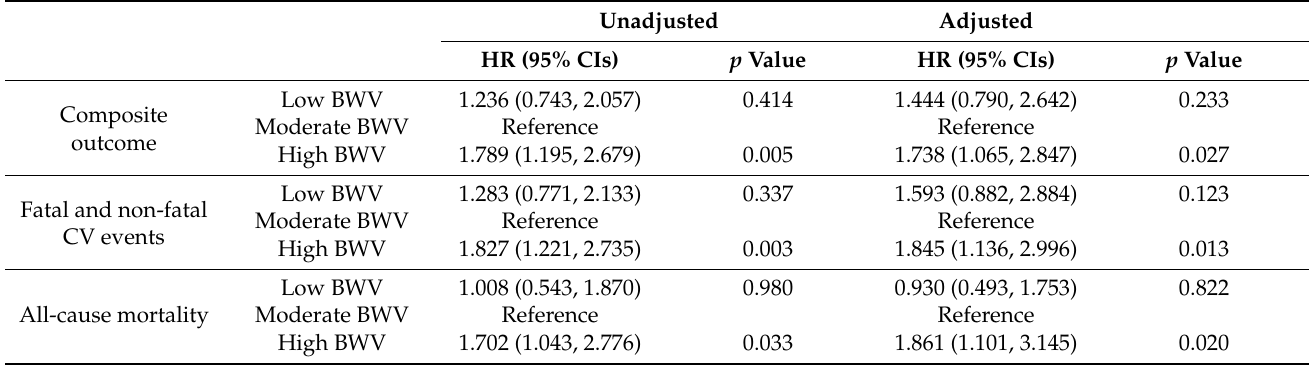
Models were adjusted for age, gender, Charlson comorbidity index, history of DM, smoking history, BMI, SBP, DBP, Medications (ACEi/ARBs, diuretics, number of antihypertensive drugs), hemoglobin, albumin, HDL-cholesterol, triglycerides, fasting serum glucose, hs-CRP, 25(OH) vitamin D levels, eGFR, and 24 h urine protein. Abbreviations: BWV, body weight variability; CV, cardiovascular; CI, confidence